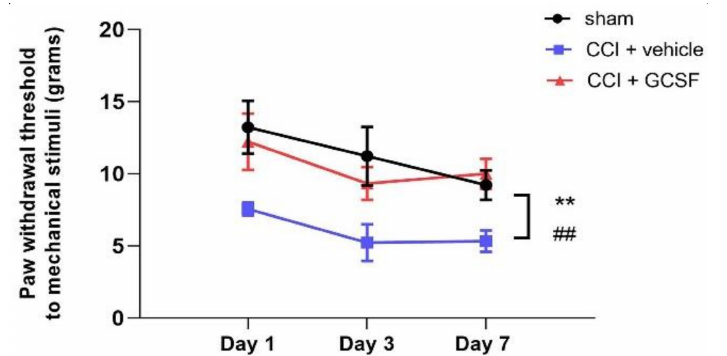
Figure 1. Early systemic G-CSF treatment alleviated mechanical allodynia in rats with chronic constriction injury (CCI) from the 1st to the 7th days after nerve injury. Significant mechanical allodynia developed in vehicle-treated CCI rats compared to sham control rats from the 1st to the 7th day after nerve injury ( ## p < 0.01: vehicle-treated CCI rats compared to sham-operated control rats). In contrast, early G-CSF treatment alleviated mechanical allodynia from the 1st to the 7th day after nerve injury compared to that in vehicle-treated CCI rats (** p < 0.01: G-CSF-treated CCI rats compared to vehicle-treated CCI rats). The data are shown as the mean ± SEM. n = 9 in each